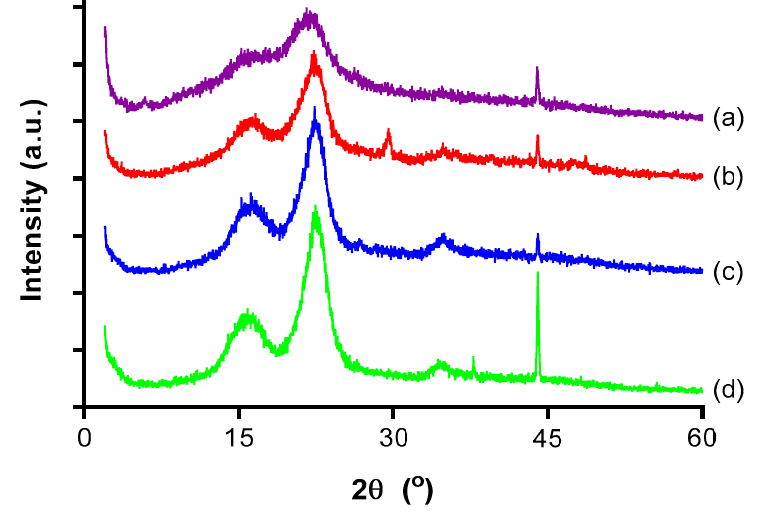
Figure 3. XRD curves of (a) OPMF, (b) alkaline treated OPMF, (c) bleached OPMF and, ( d ) CNC.